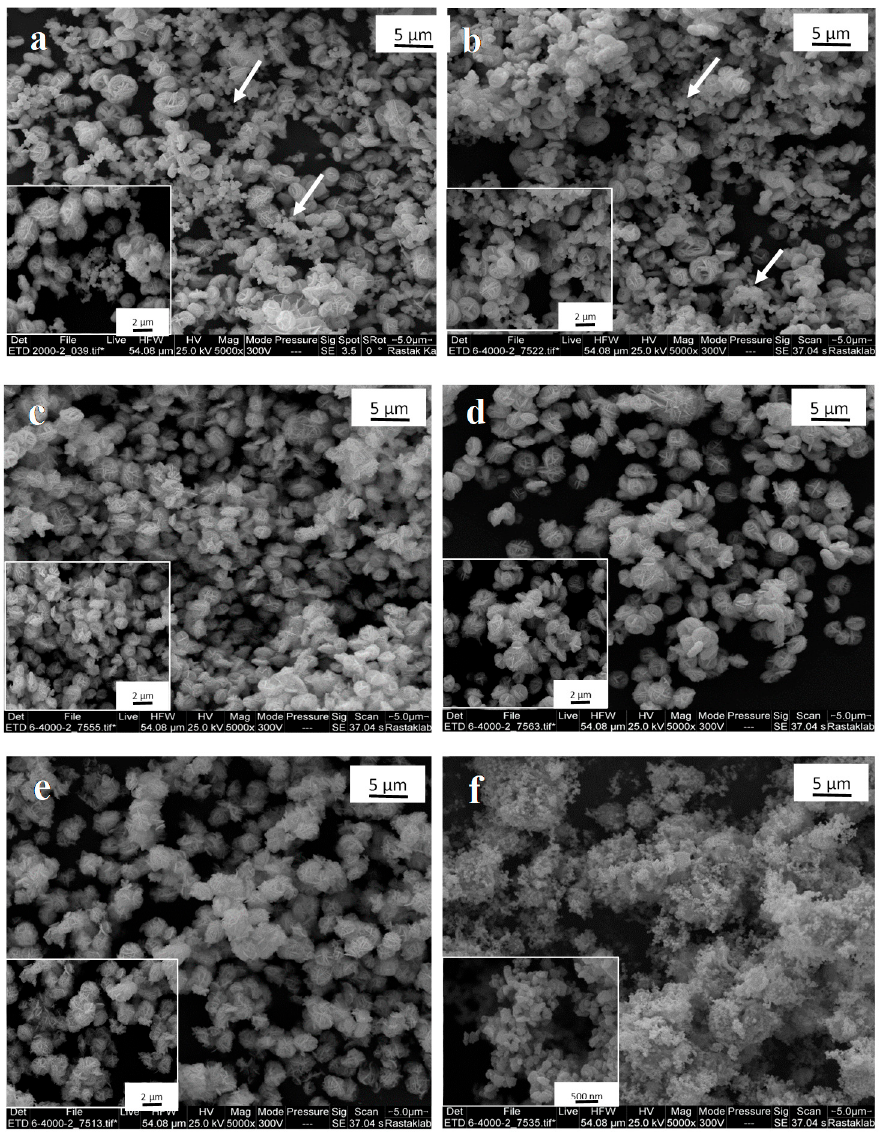
Figure 2. Scanning electron microscopy (SEM) images of Bi 2 WO 6 samples prepared under di ff erent conditions: ( a ) BWO1, ( b ) BWO2, ( c ) BWO3, ( d ) BWO4, ( e ) BWO5, and ( f ) BWO6.